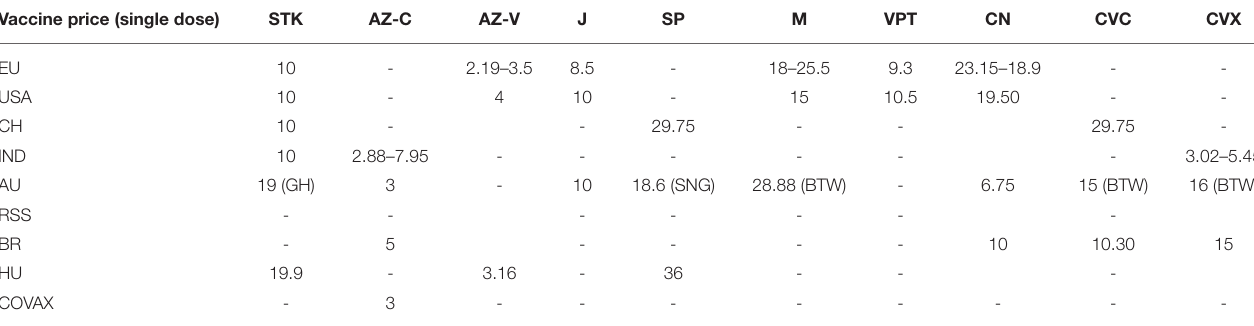
TABLE 1 | Prices of vaccines in different countries in US dollars ($). Vaccine price (single dose) STK AZ-C AZ-V J SP